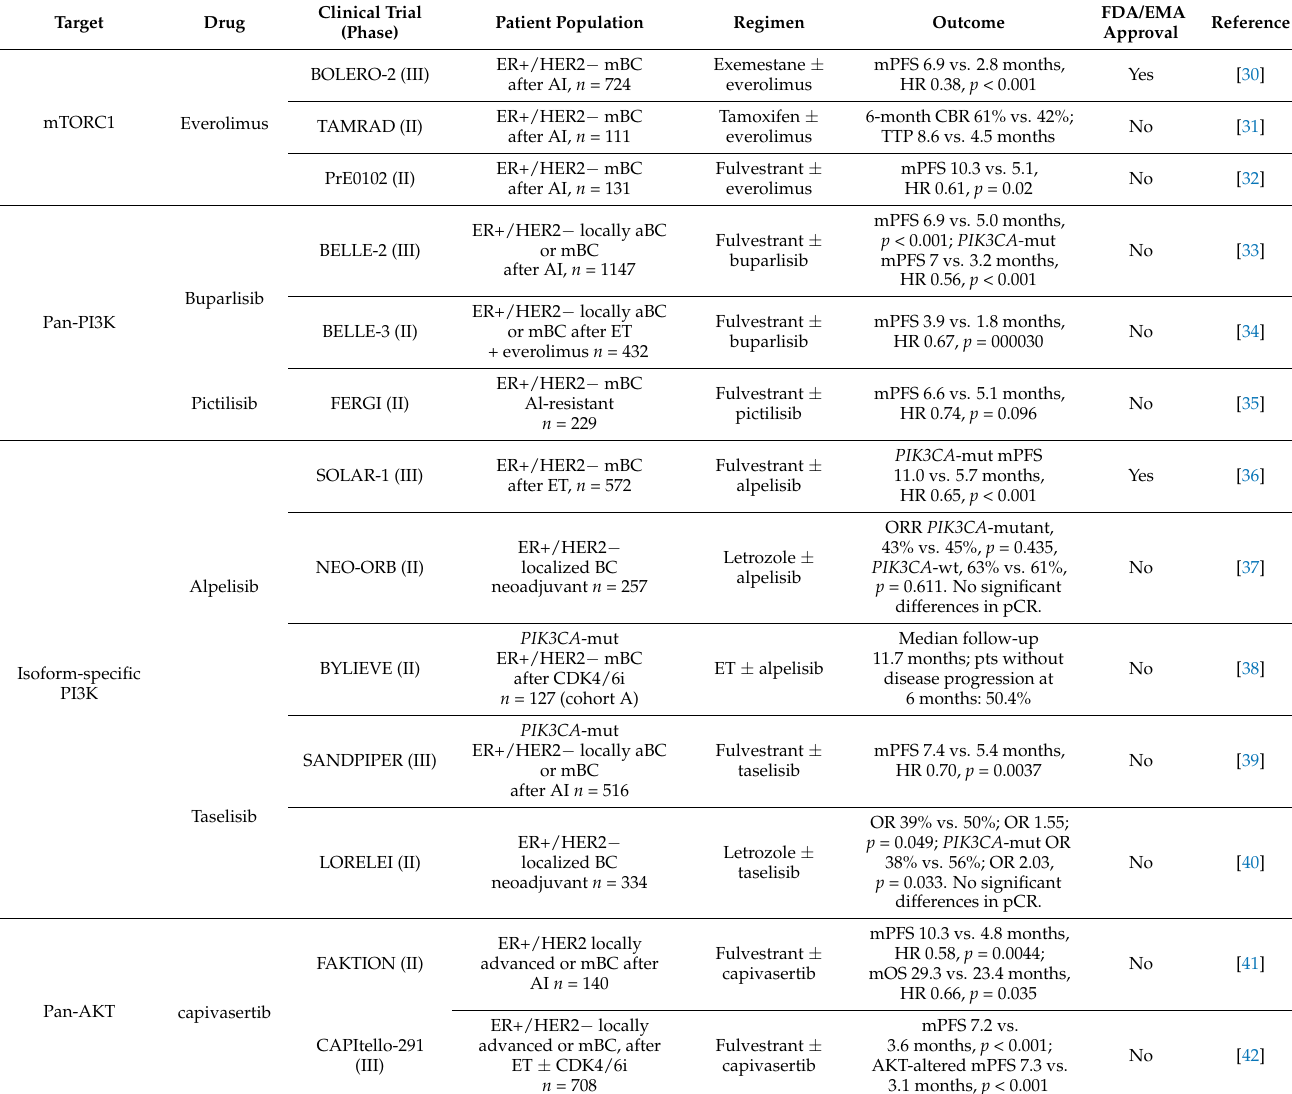
Table 1. Selected clinical trials with PI3K/AKT/mTOR inhibitors in ER+/HER2 − advanced breast